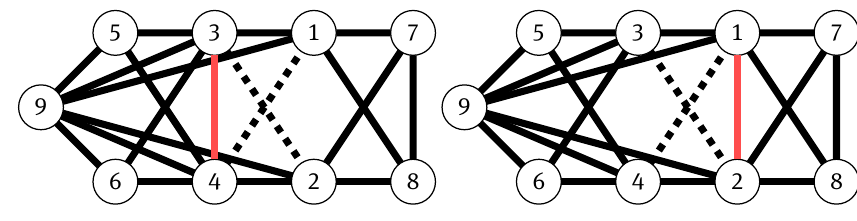
Figure 4: Three D L -cospectral pairs on 9